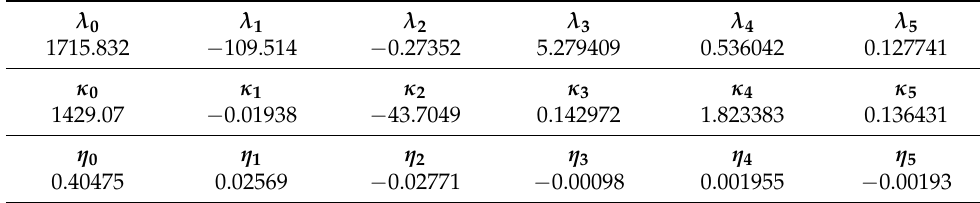
Table 3. Optimization parameter values.